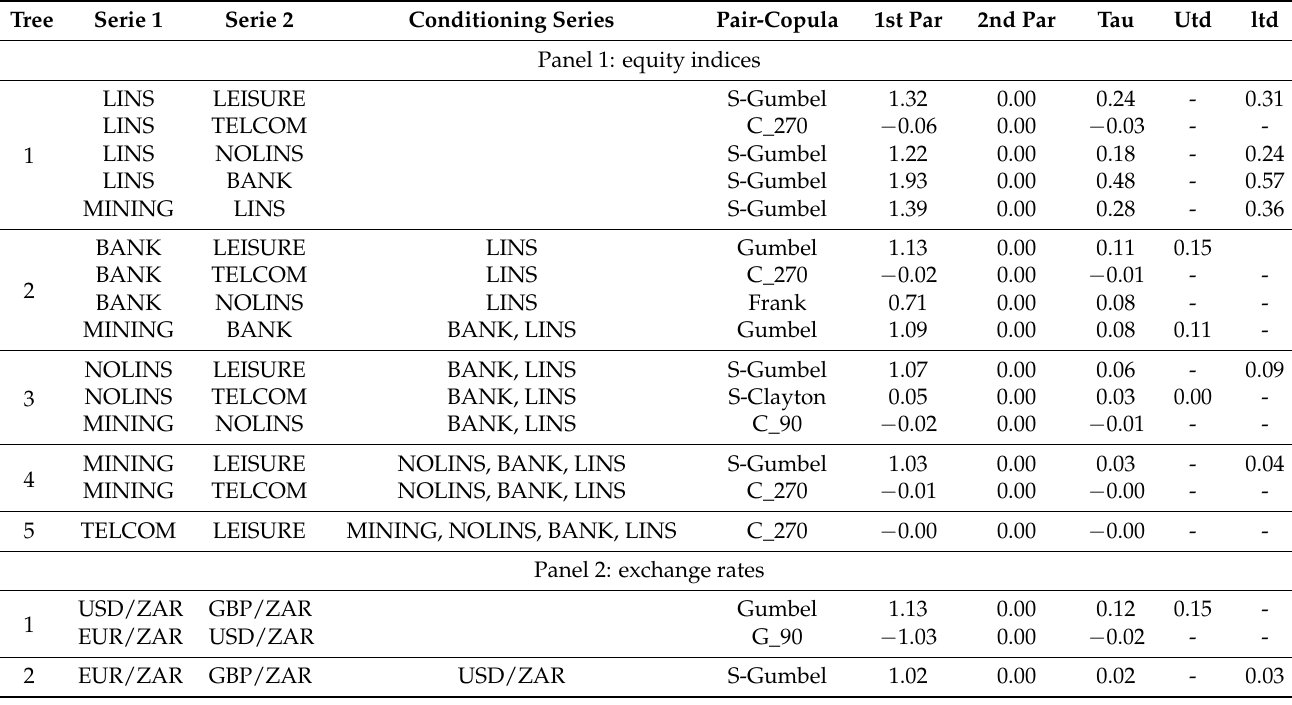
Table A3. Parameter estimates of the dependence structures using D-vine